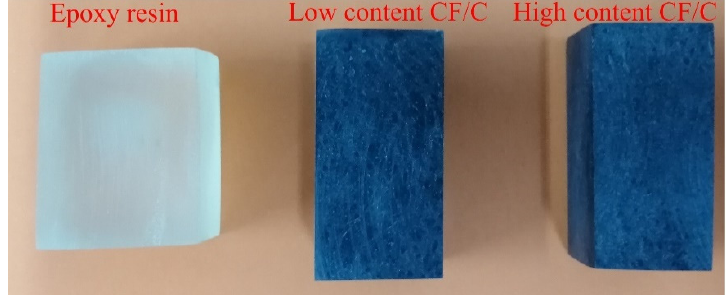
Figure 3. The physical image of the cured resin and the CF/C/EP composites.